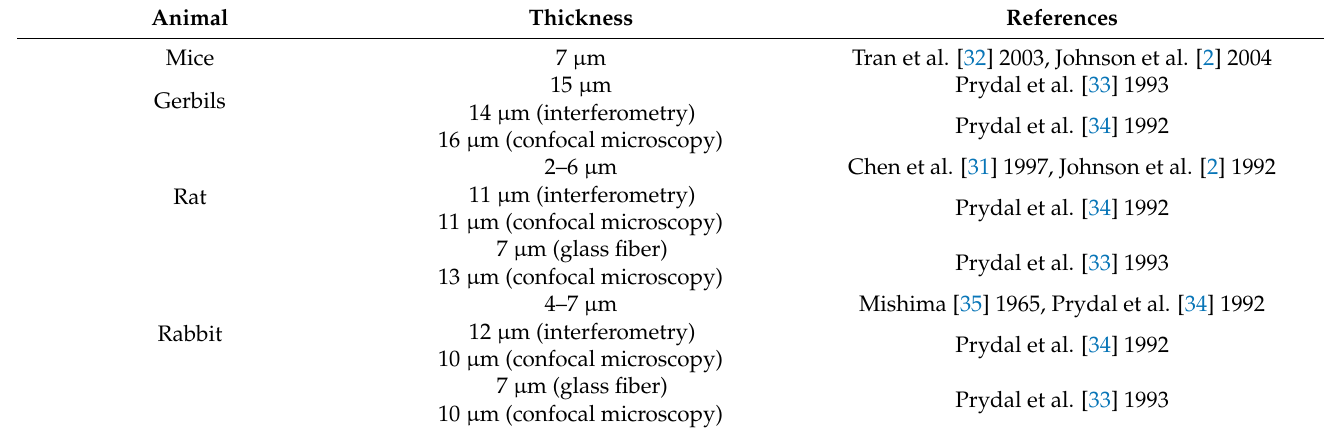
Table 1. Thickness of tear film in different